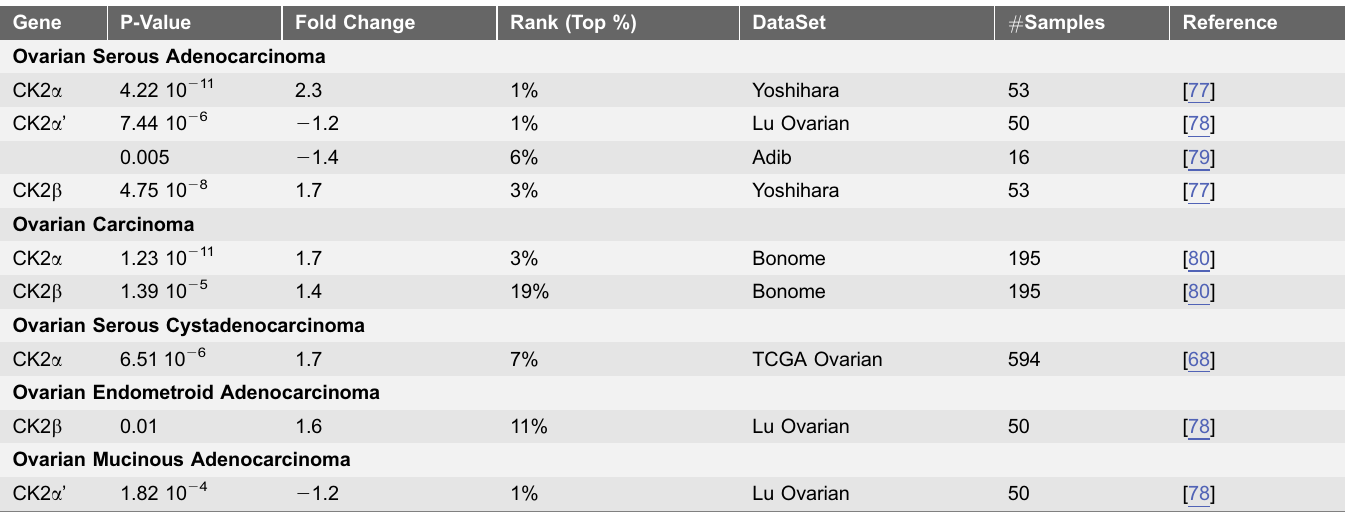
Table 5. Changes in CK2 gene expression in ovarian cancer. Gene P-Value Fold Change Rank (Top